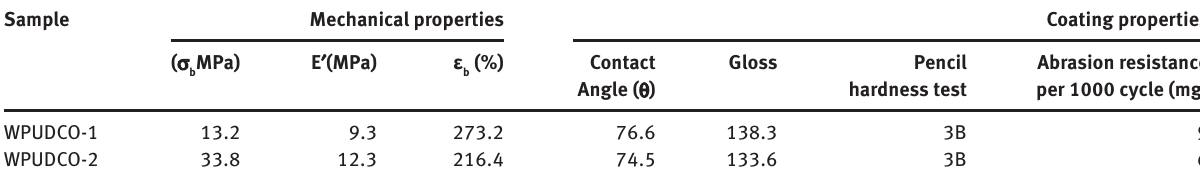
Table 4: Mechanical and coating properties of polyurethane (PU)-prepolymer. Sample